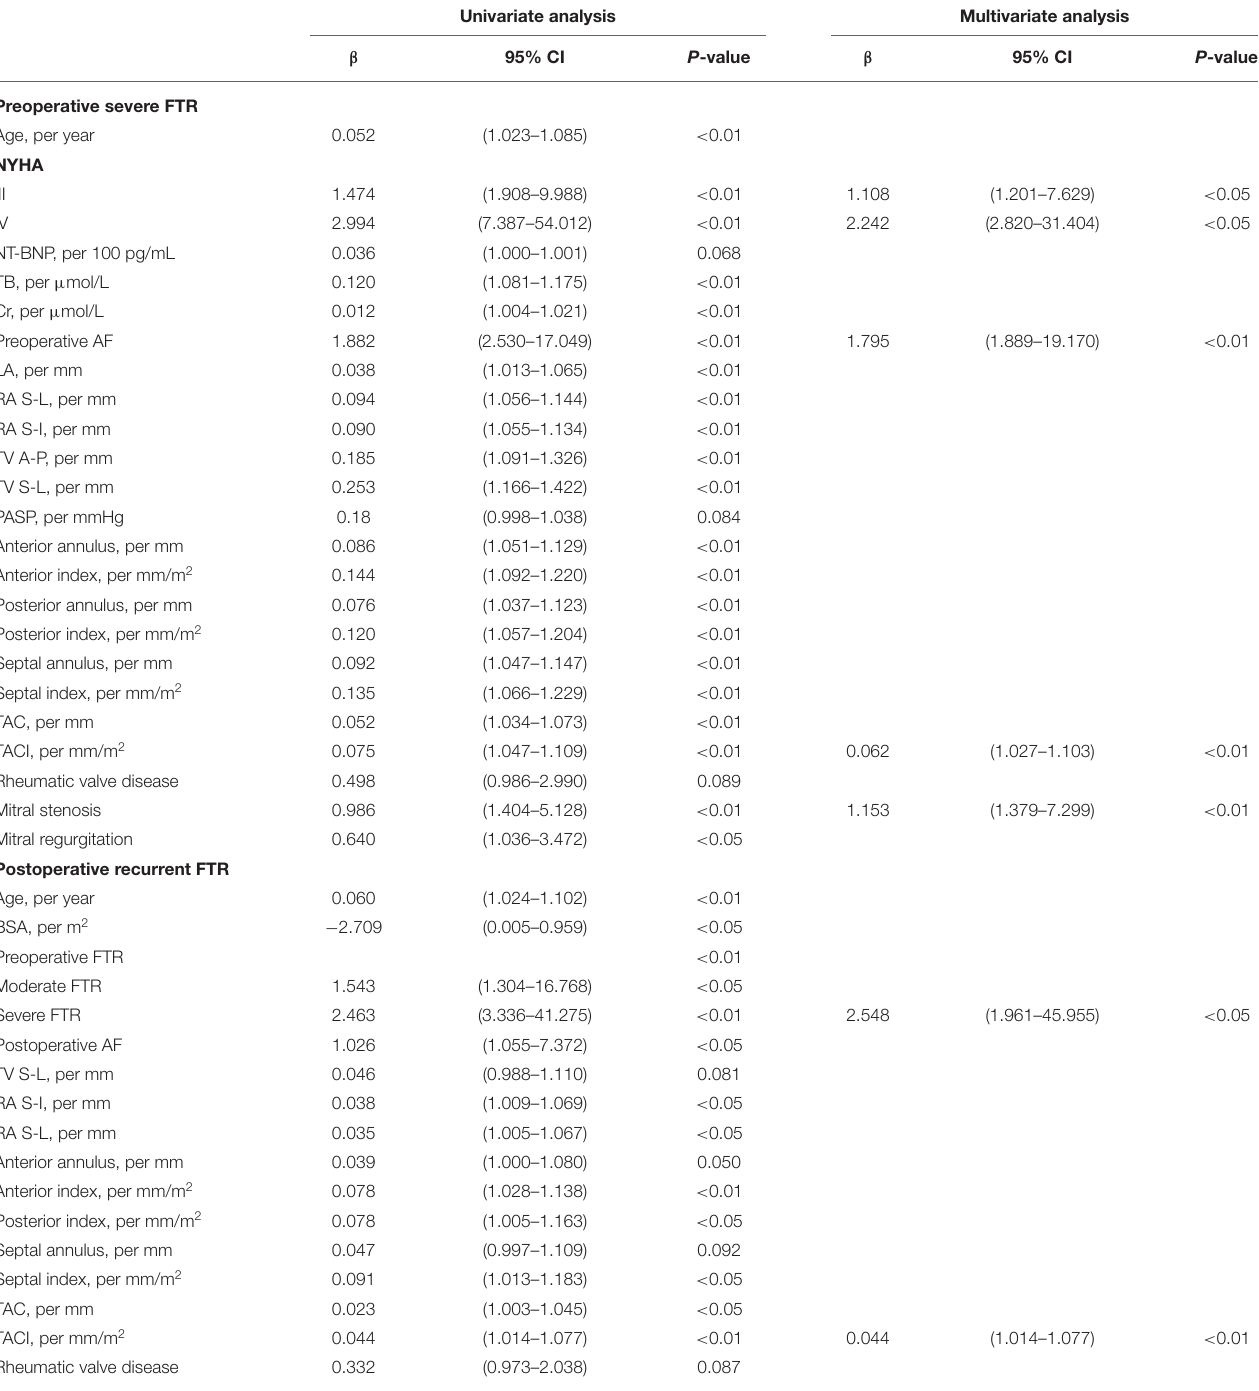
TABLE 3 | Univariate and multivariate analysis of risk factors of severe FTR. Univariate analysis Multivariate